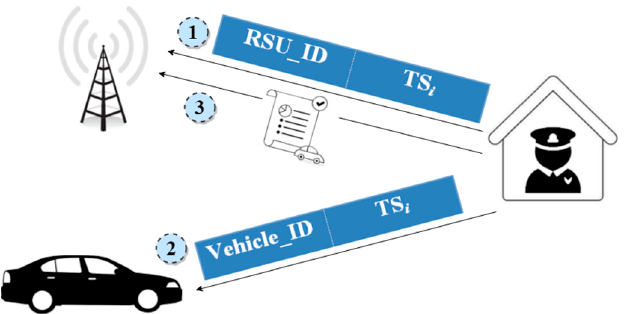
Figure 2. Authorization Phase.